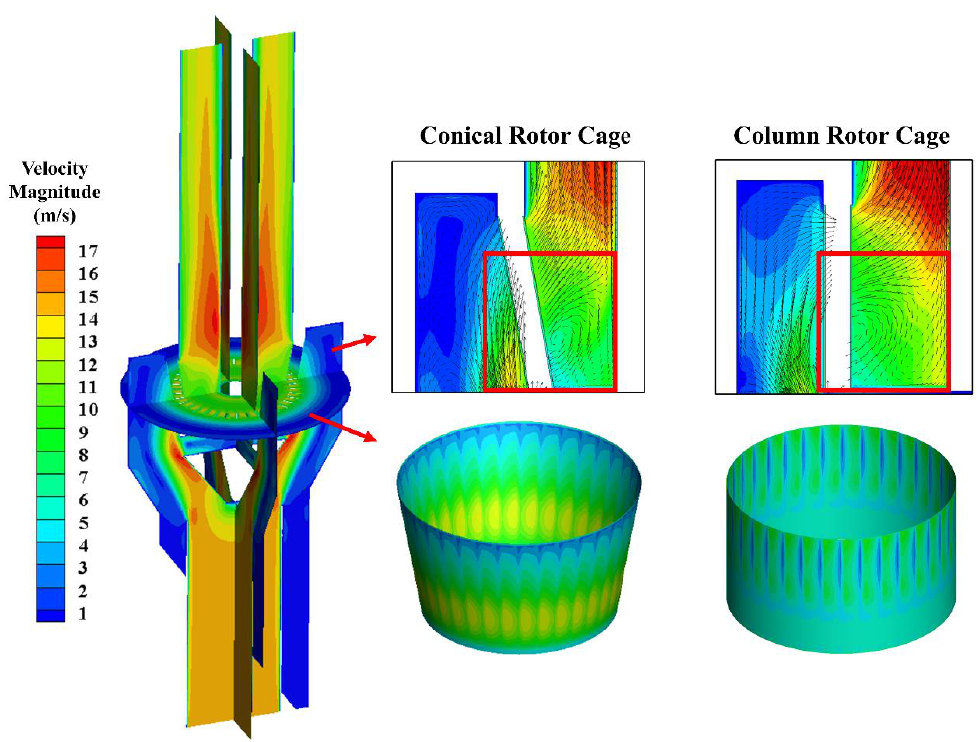
Figure 5. Cloud diagram for the high-efficiency rotor classifier with different cross-sectional velocities and local velocity vectors.